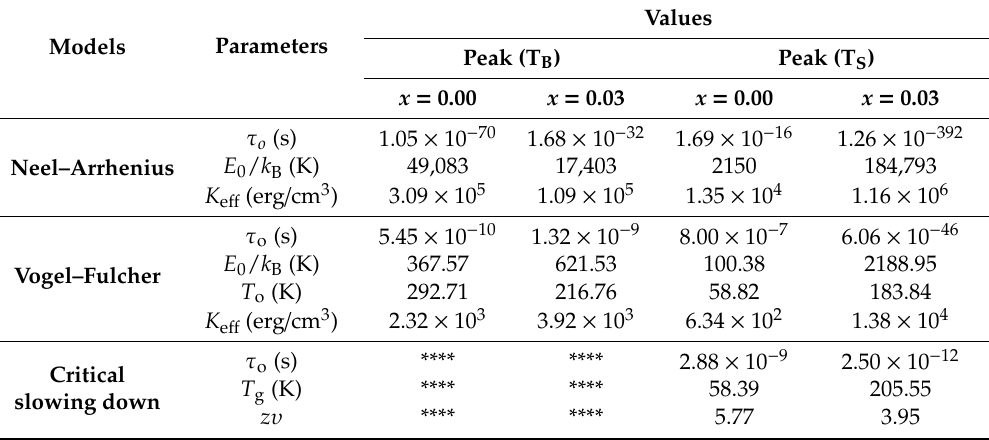
Table 3. Fitting parameters ( 𝜏 (cid:2925) , 𝐸 (cid:2868) /𝑘 (cid:2886) and 𝐾 (cid:2915)(cid:2916)(cid:2916) ) of prepared NiFe 2 − x Dy x O 4 ( x = 0.00 and 0.03) NPs estimated using different laws.